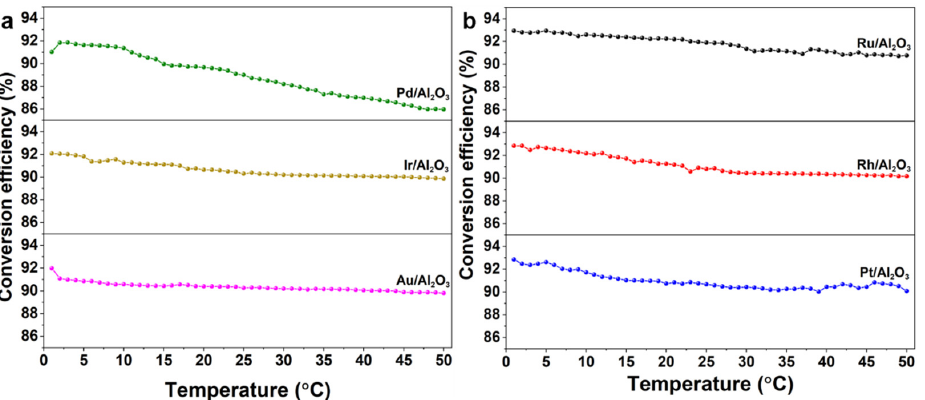
Figure 2. 1,2-DCE conversion curves of (a) Au/ γ -Al 2 O 3 , Ir/ γ -Al 2 O 3 , and Pd/ γ -Al 2 O 3 catalysts and (b) Pt/ γ -Al 2 O 3 , Rh/ γ -Al 2 O 3 , Ru/ γ -Al 2 O 3 catalysts.